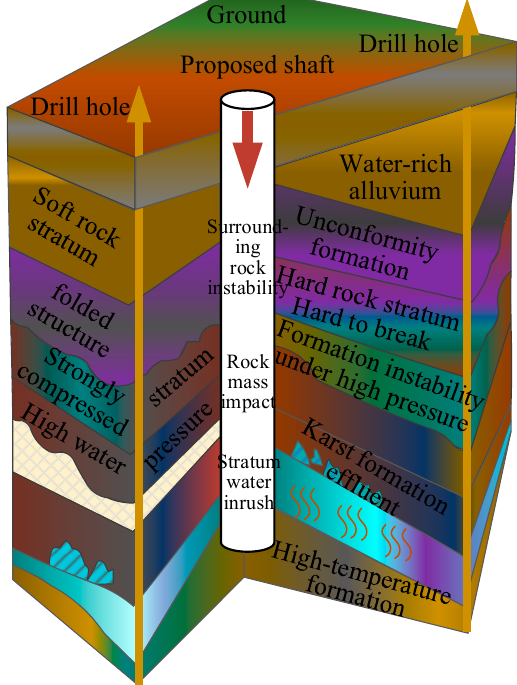
Figure 1. Schematic diagram of complex formation composition and structure.